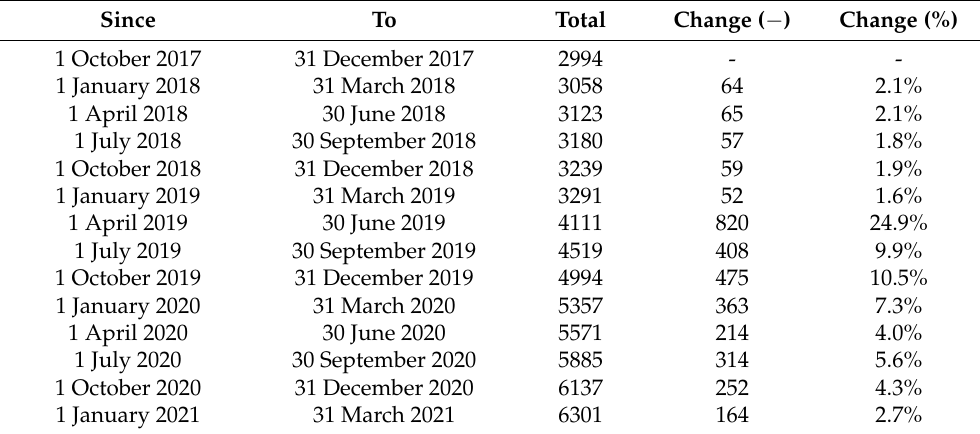
Table 2. Quarterly numbers of issued taxi service concessions in Slovakia. Source: processed by authors.